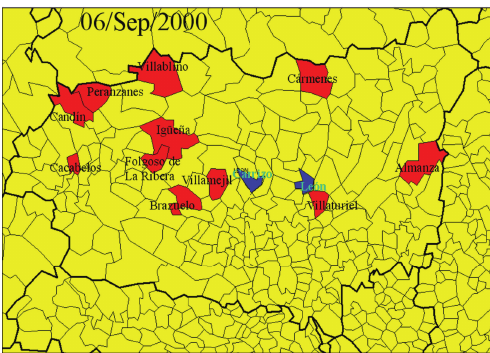
Figure 2: Example of a map representing the districts in the province of Le´on, Spain, with active wildfires on 6th September 2000. The probe was installed in